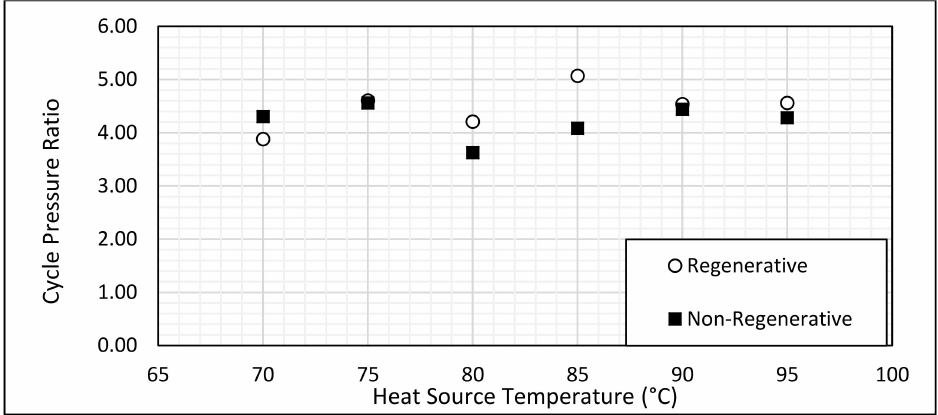
Figure 9. Variation in cycle pressure ratio with changing heat source